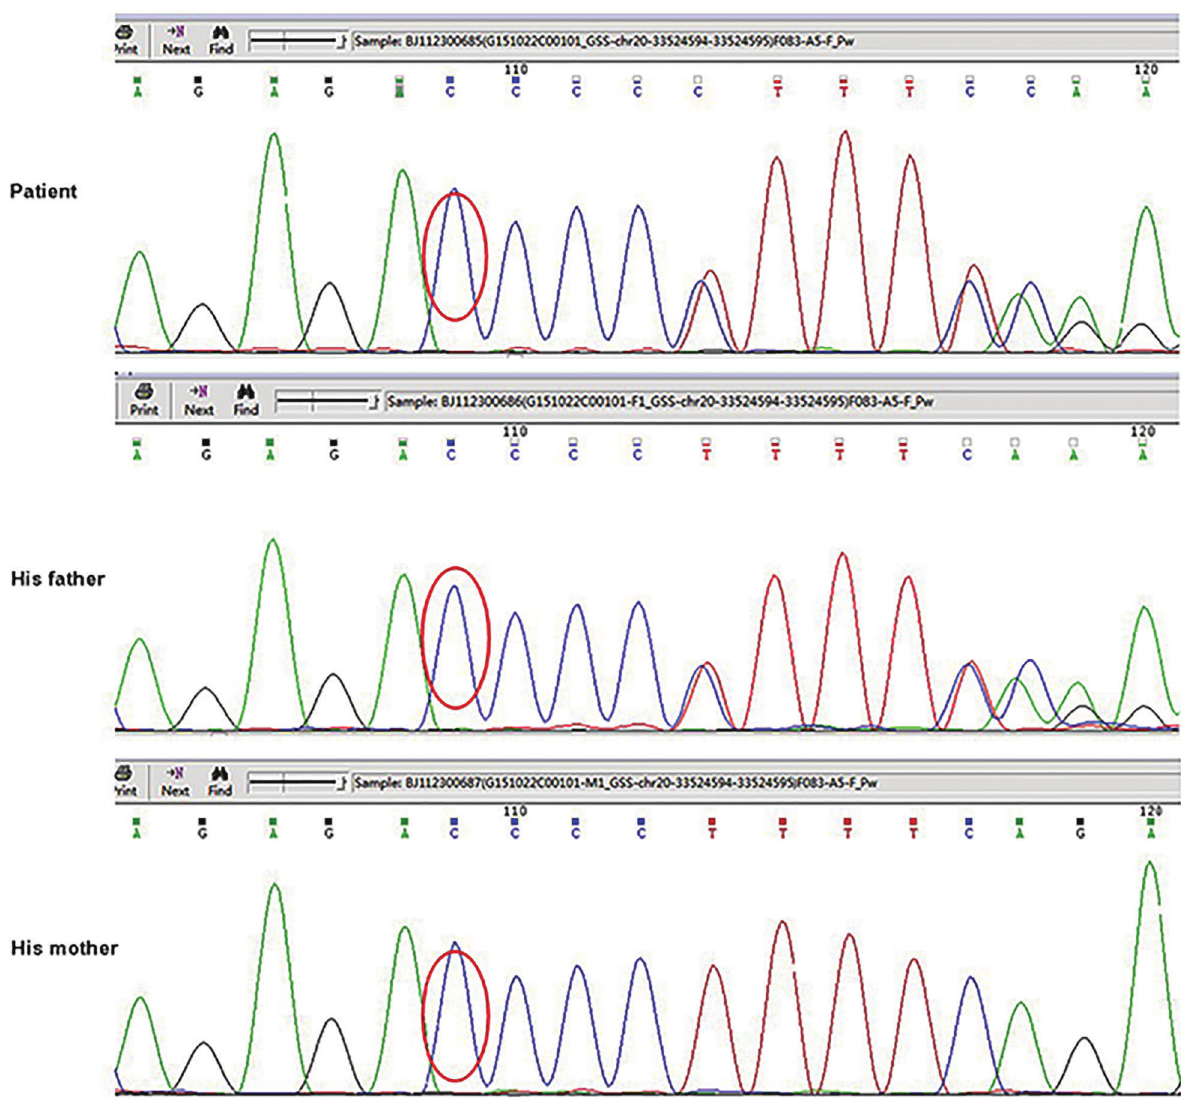
Figure 1. DNA sequence analysis of the patient and his parents. Nucleotide sequence showed heterozygous c.738dupG mutation in exon 8 of GSS gene in the patient and his